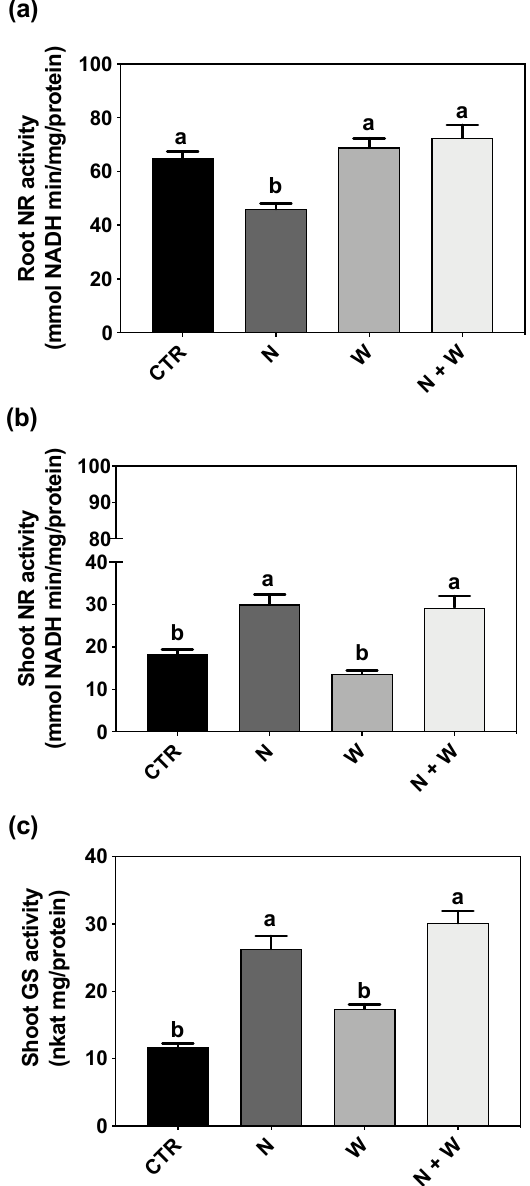
Figure 6. Nitrate reductase (NR) activity in roots ( a ) and shoots ( b ) and glutamine synthase (GS) activity in shoots ( c ) of tomato cv. Micro-Tom grown for 16 days under control (CTR; 10.5 mM N + 100% W), nitrogen deficit (N; 5.3 mM N + 100% W), water deficit (W; 10.5 mM N + 50% W) or combined nitrogen and water deficit (N+W; 5.3 mM N + 50% W). Data presented are mean ± SEM (n = 3). Different letters above bars indicate significant differences according to Tukey’s HSD test ( p = 0.05). GS activity was not detectable in roots (i.e., below the limit of detection of the method).